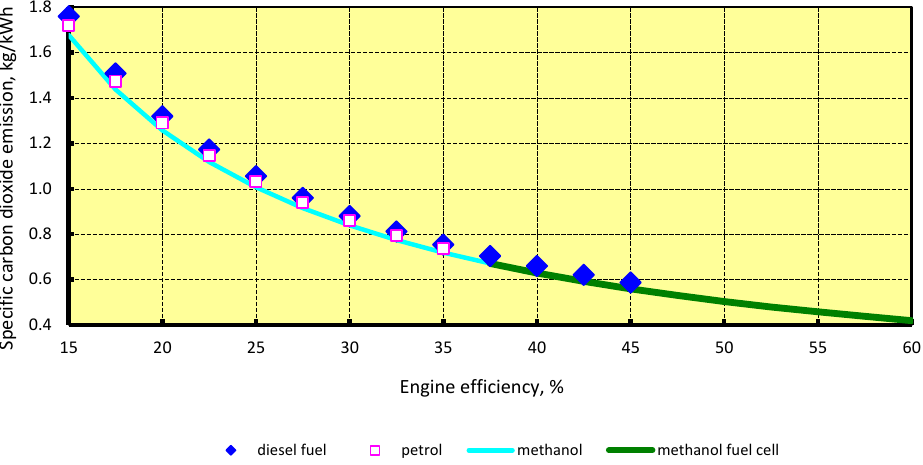
Figure 4. Specific tank-to-wheel carbon dioxide emissions.